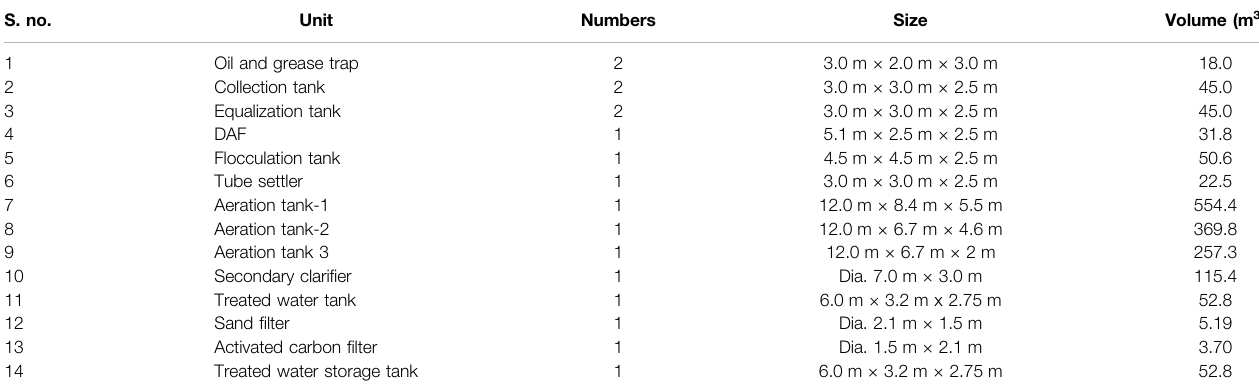
TABLE 2 | Unit sizes of Al Noor 500 m 3 /d, ETP. S. no.